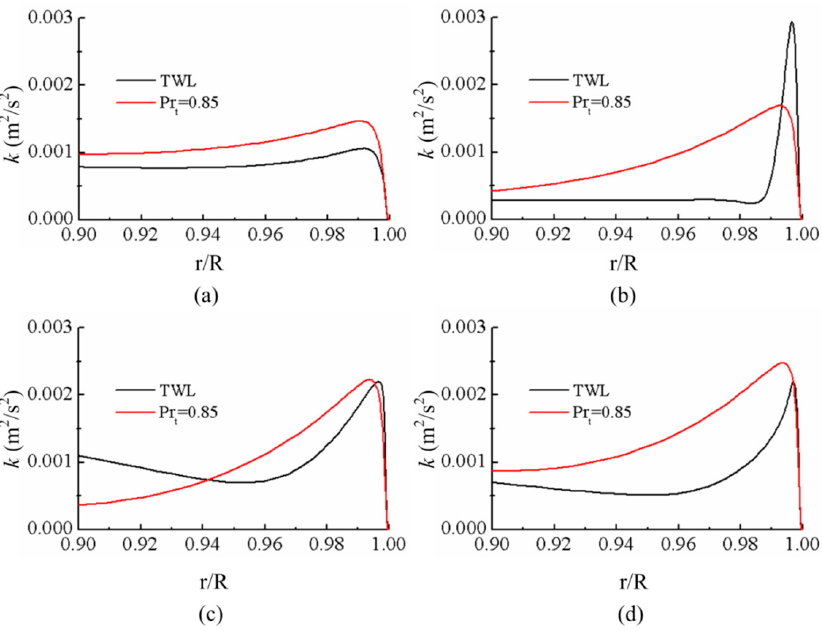
Figure 9. Distribution of turbulent kinetic energy in different sections: ( a ) x/D = 13; ( b ) x/D = 26; ( c ) x/D = 39; ( d ) x/D = 79.